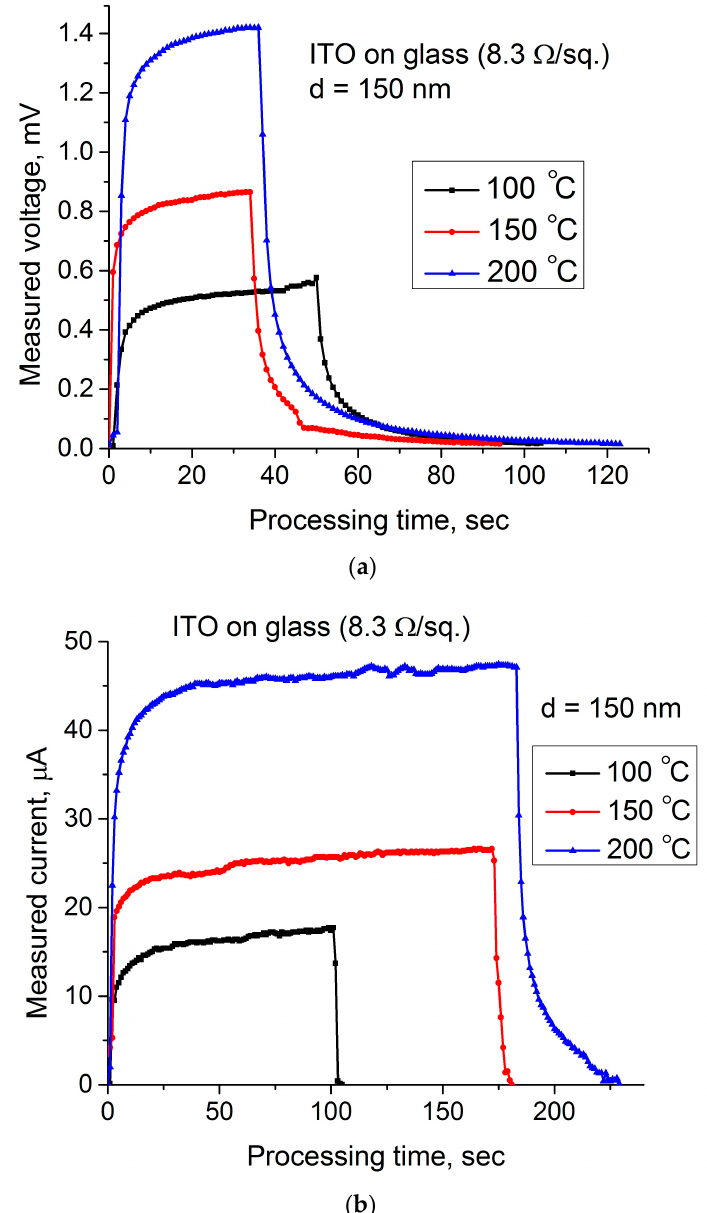
Figure 3. Dynamic hot-probe characteristics of the commercial ITO coatings: ( a ) a voltage measured between hot and cold electrodes; ( b ) a current between electrodes.